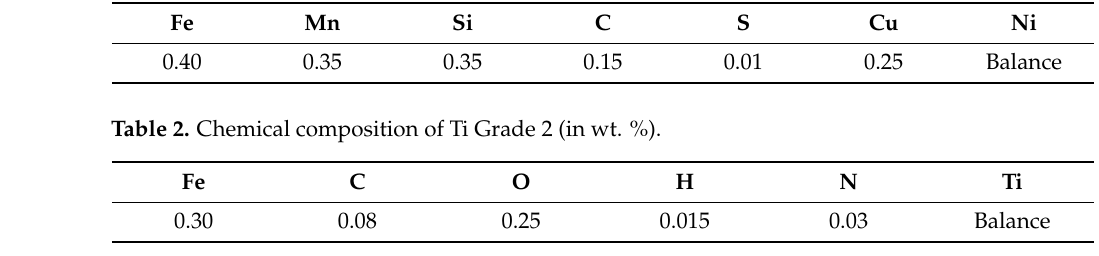
Table 1. Chemical composition of Ni 201 alloy (in wt. %).